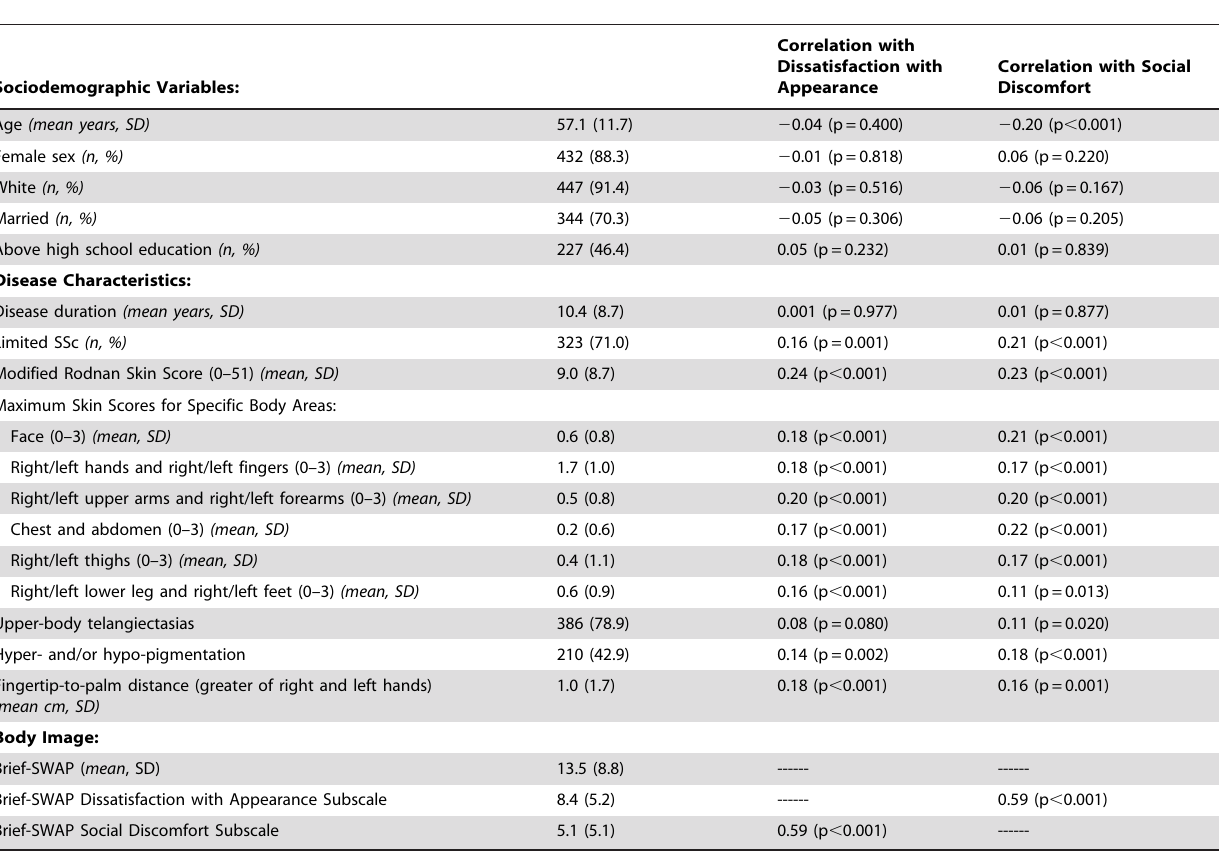
Table 1. Sociodemographic Variables, Disease Characteristics for SSc Patients, and Pearson Correlations with Brief-SWAP Subscales (N= 489).